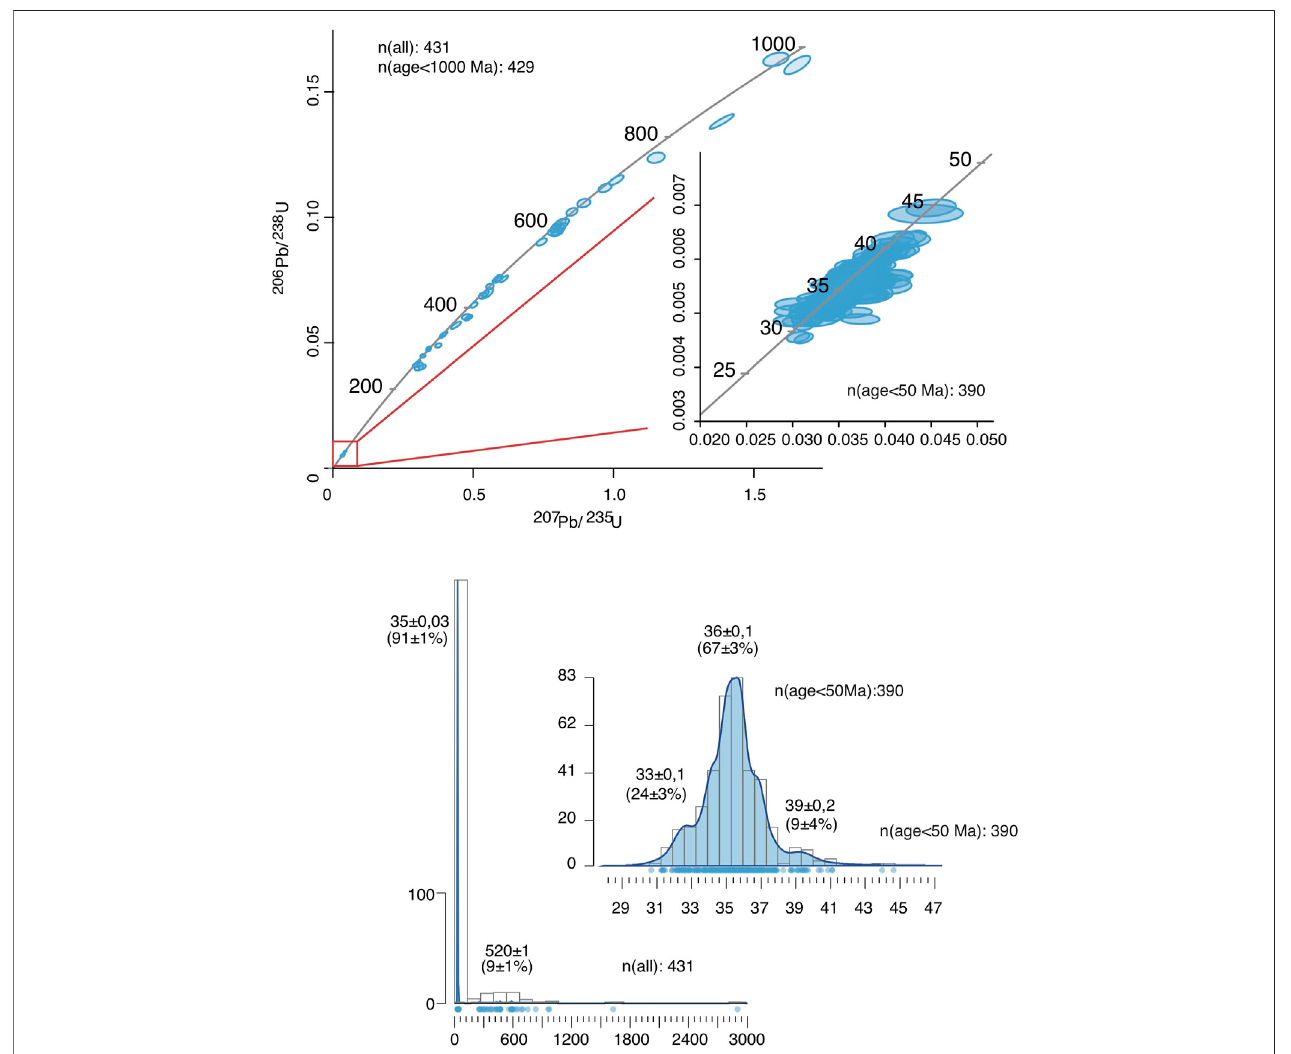
FIGURE 8 | Concordia and isochron diagrams for U-Pb dating of zircons (above). Ellipses (correlated errors) correspond to two sigma -STERR of the mean ratios. Linear regression calculations were performed with ISOPLOT-3 (Ludwig, 2001). Distribution of ages in the last 50 Ma show a peak at 36 Ma (below).